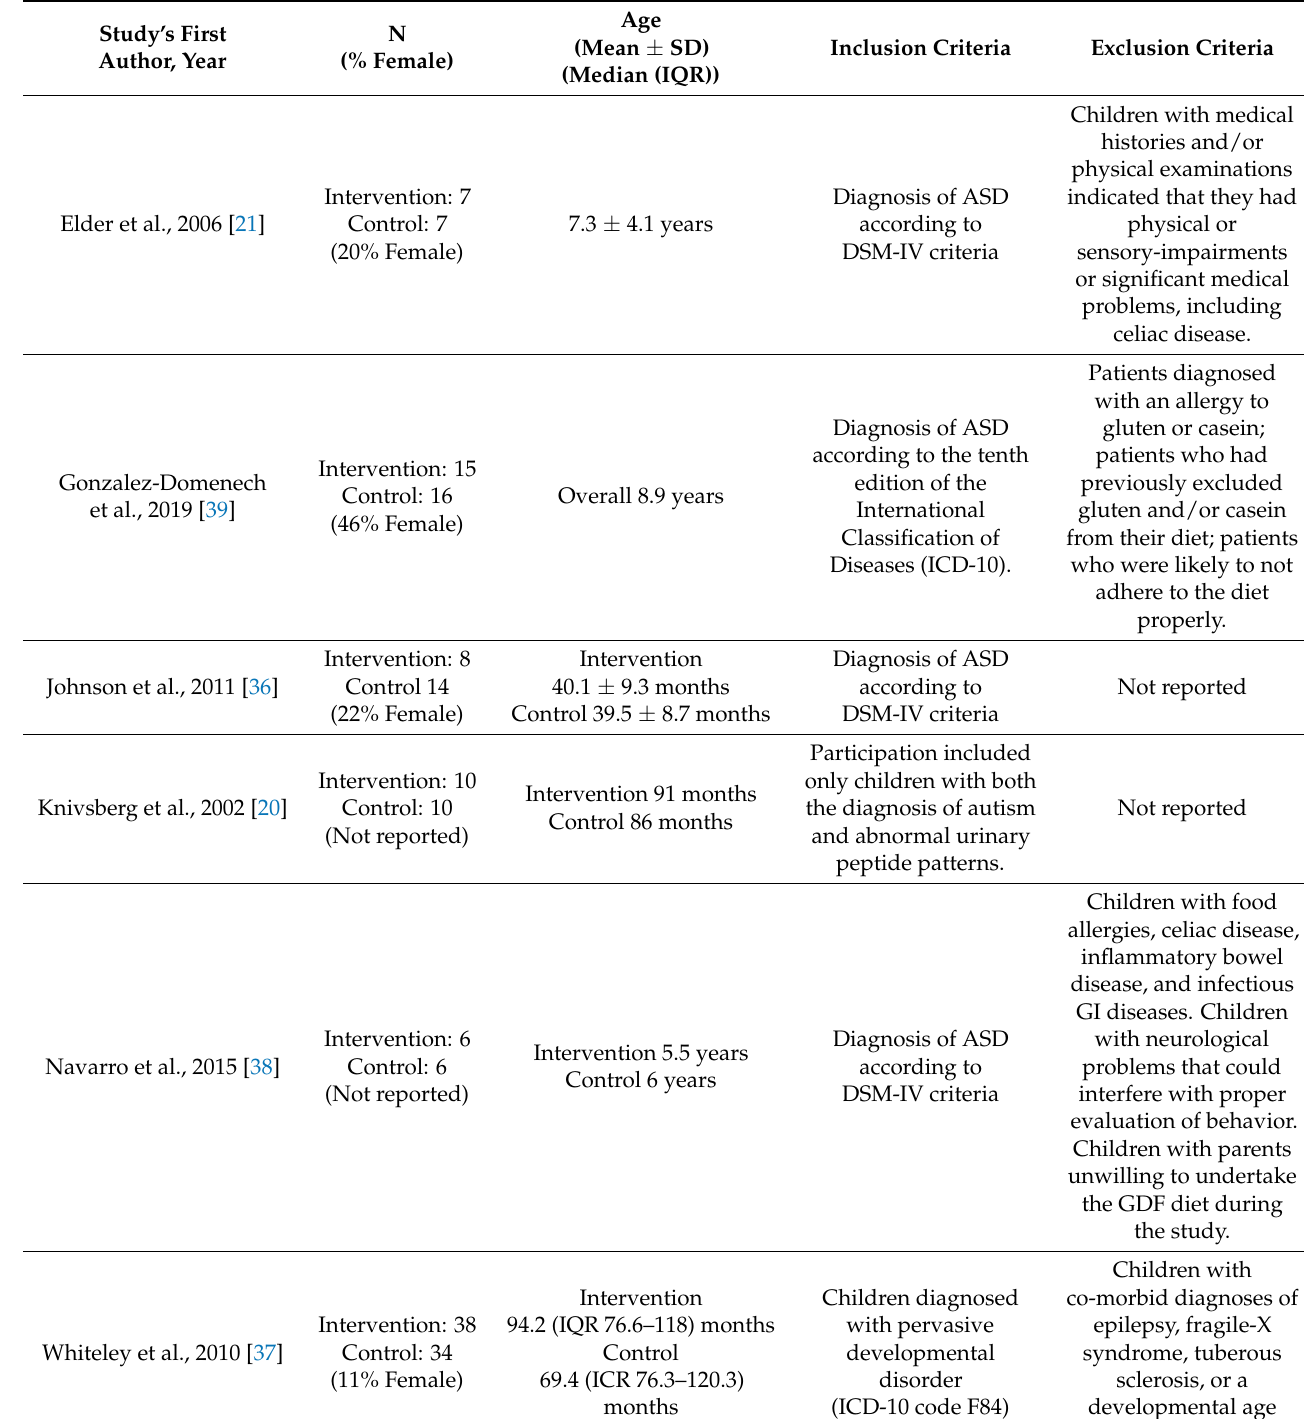
Table 2. The baseline characteristic of the six included